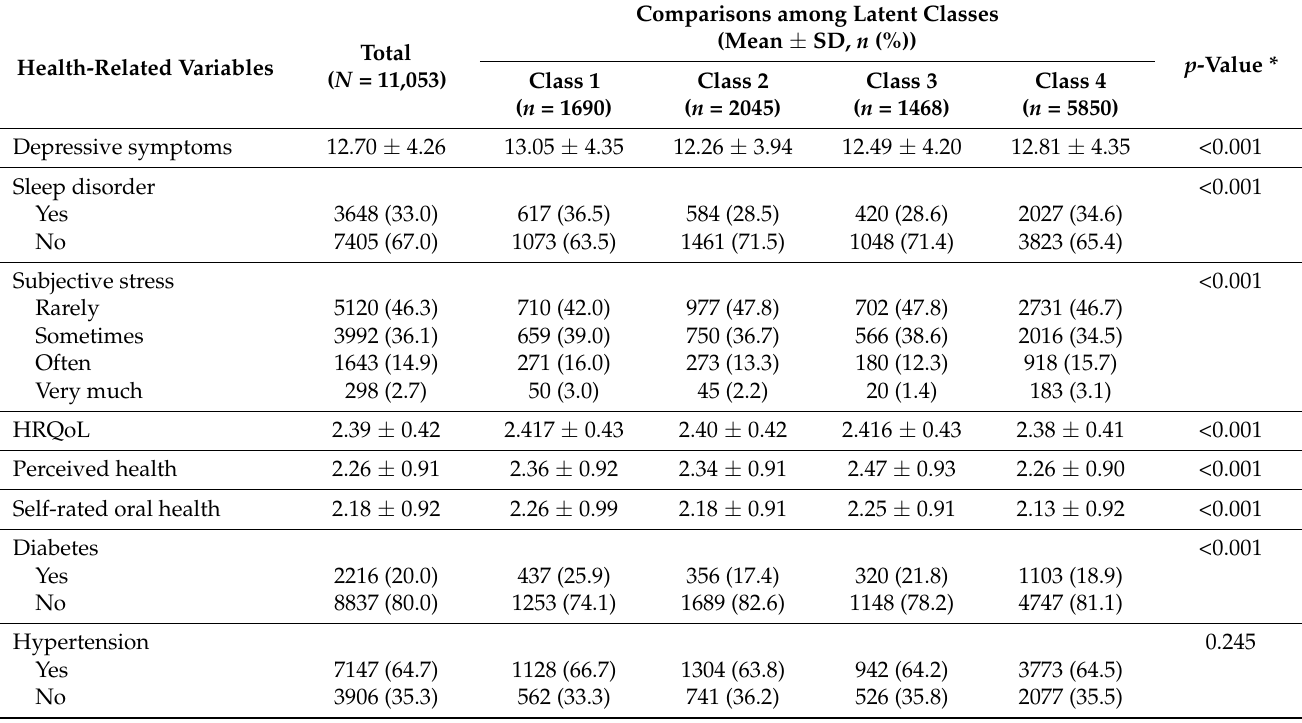
Table 4. Inter-class health characteristic